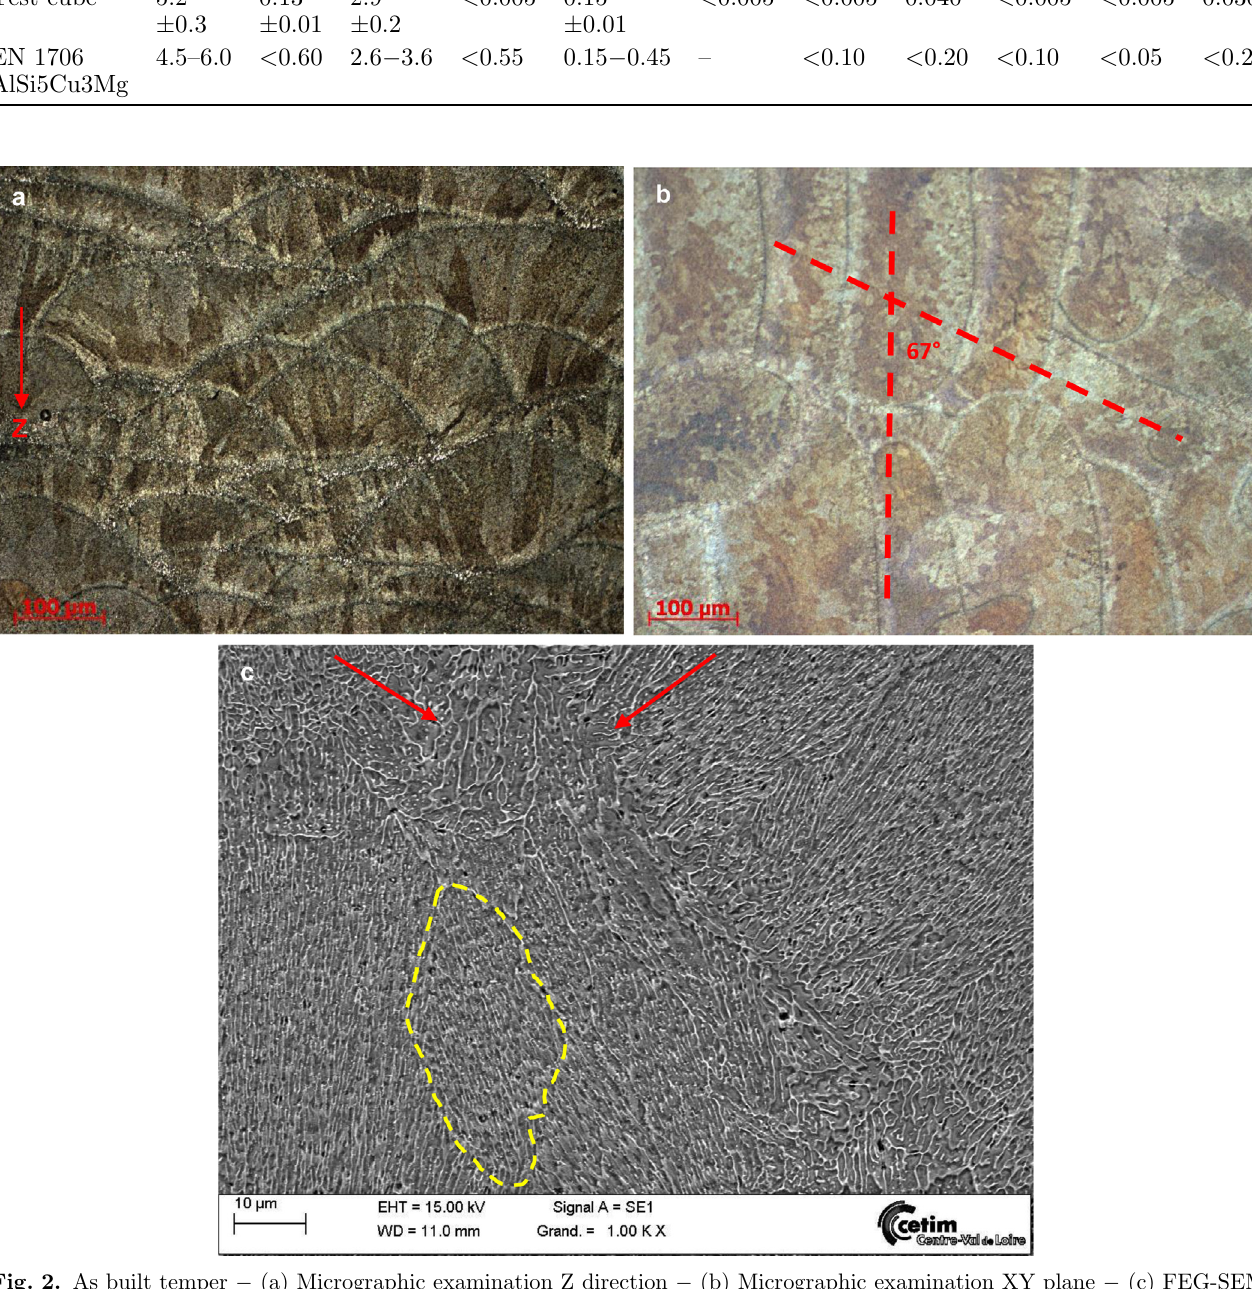
Table 3. Chemical composition of the AlSi5Cu3Mg alloy after LPBF (cid:1) As-built temper. % by weight Si